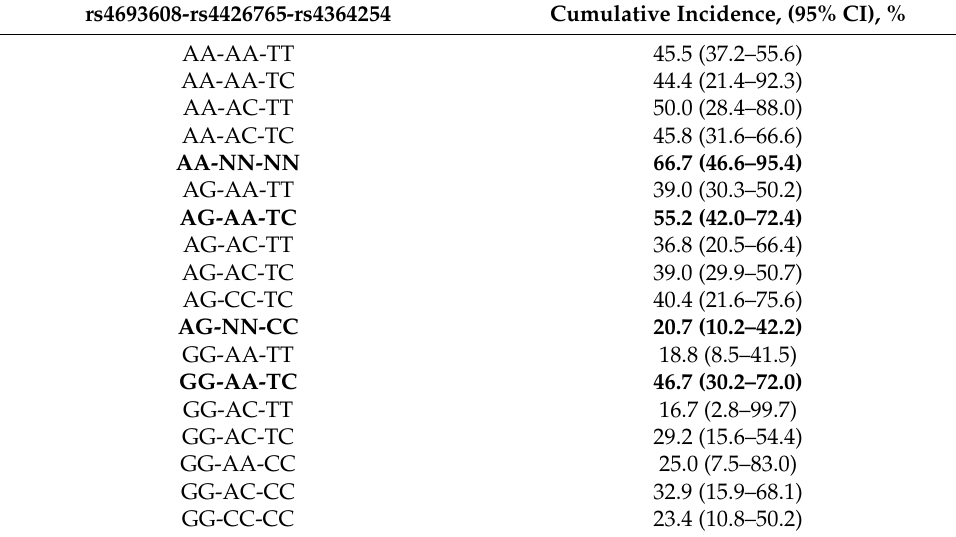
Table 3. Univariate analysis of cumulative incidence of clinically significant (II-IV) acute GVHD: examination of interaction between patient rs4693608, rs4426765, and rs4364254